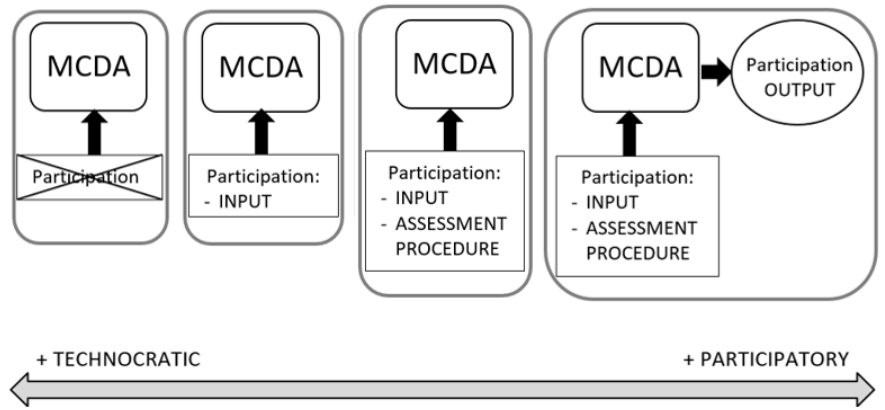
Figure 2. Classification of Multicriteria Decision Analysis (MCDA) (presented in Figure 3) according to degree of participation.